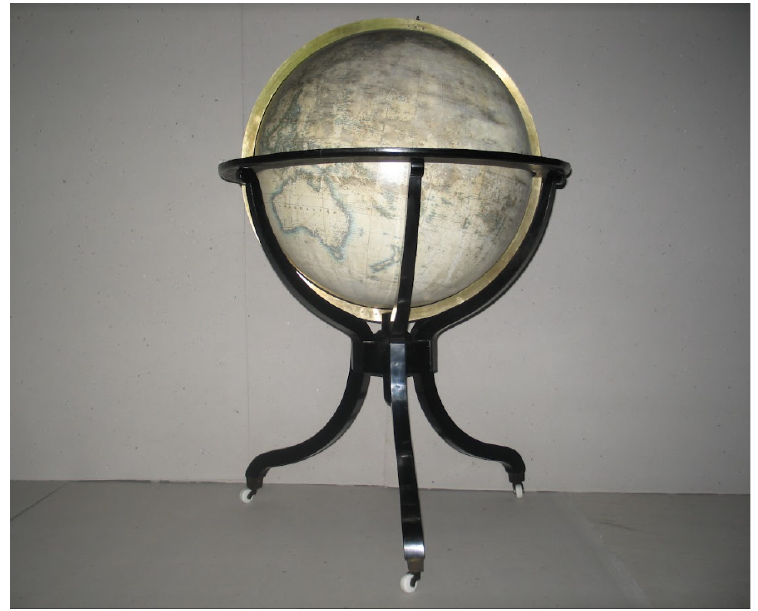
Figure 2 . Overall view of the restored terrestrial globe by J. Jüttner, 1839. Source: Map Collection of the Faculty of Science, Charles University.